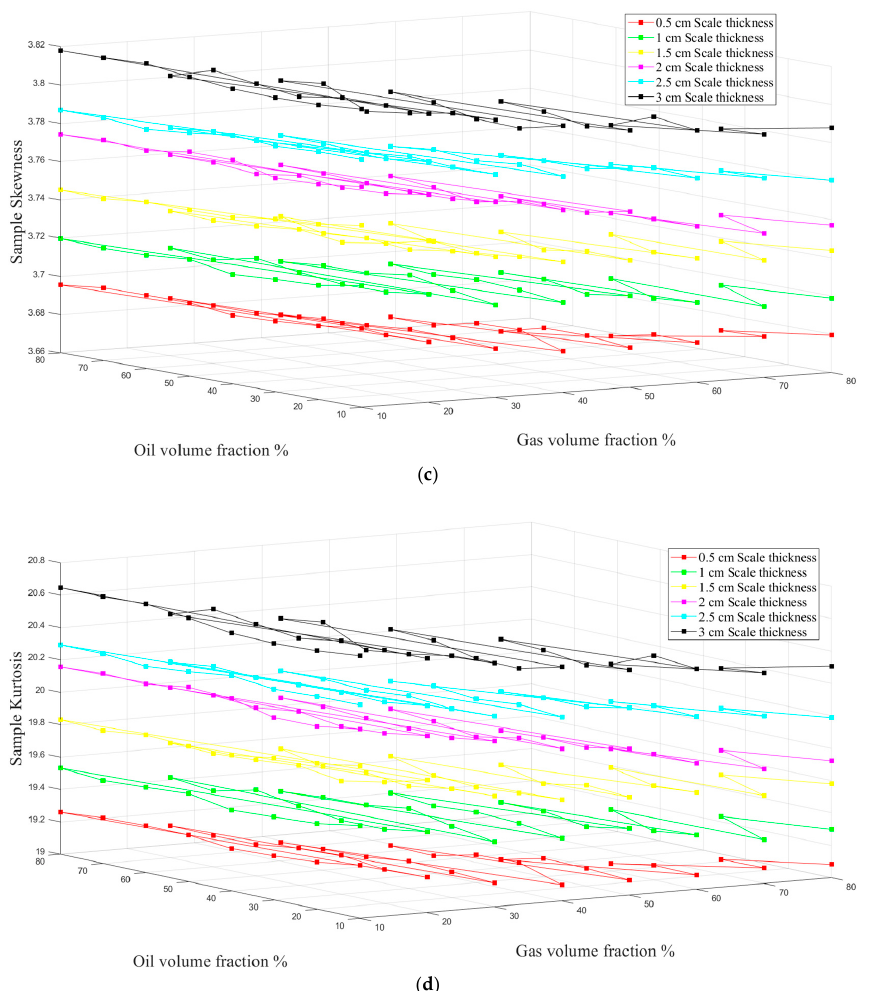
Figure 3. Extracted temporal characteristics in terms of volume percentage of gas and oil ( a ) sample mean, ( b ) sample SSR, ( c ) sample skewness, and ( d ) sample kurtosis.